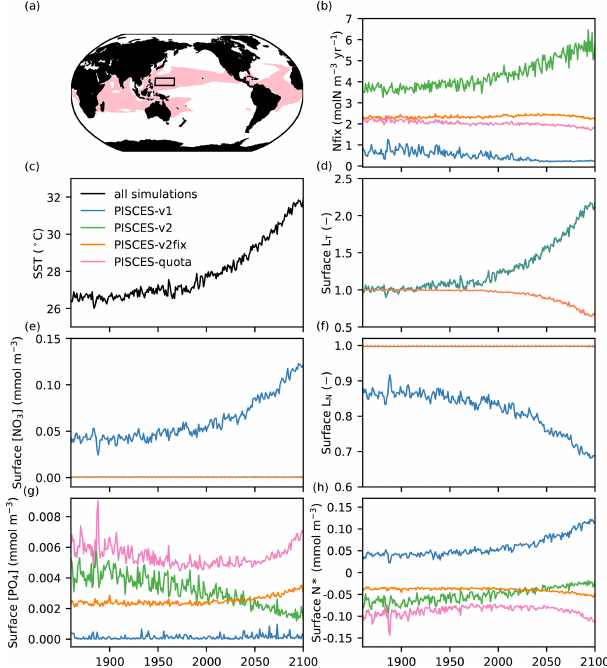
Figure 5. Mechanisms explaining the contrasting response of N fixation across the different PISCES versions. (a) Regions where IPSL-CM5A and IPSL-CM6A simulate an N-fixation re- sponse of opposing sign (red) and where the detailed analysis is performed (130–160 ◦ E, 10–20 ◦ N; black box). (b) N fixation (molNm − 3 yr − 1 ) in the different PISCES versions. (c) Sea surface temperature ( ◦ C) in IPSL-CM5A and (d) relative change in sur- face L T (no unit) for PISCES-v1 (blue) and PISCES-v2 (green) and PISCES-v2fix (orange) and PISCES-quota (pink). (e) Surface NO 3 concentration (mmolm − 3 ), (f) surface L N (no unit), (g) surface PO 4 concentration (mmolm − 3 ) and (h) surface N ∗ (mmolm − 3 ) in all PISCES versions. All (from b to h ) are annual-mean time series averaged over 130–160 ◦ E and 10–20 ◦